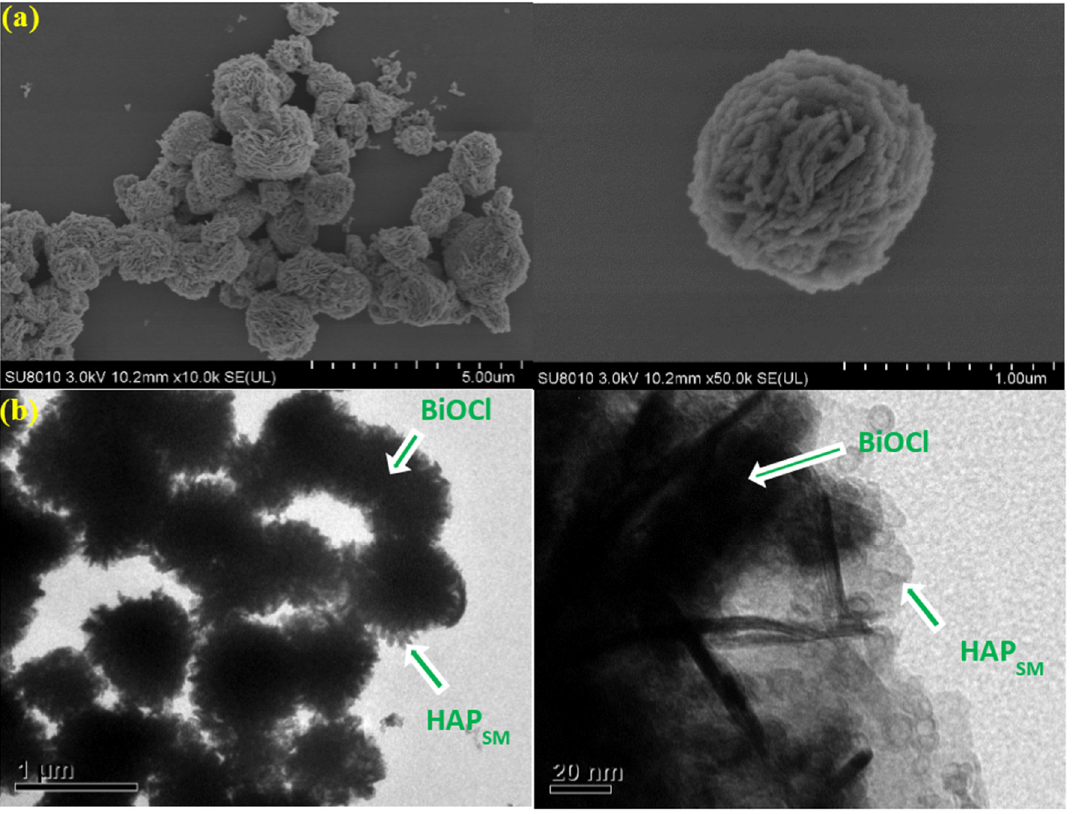
Figure 1. ( a ) SEM and ( b ) TEM images of BiOCl-HAP SM .